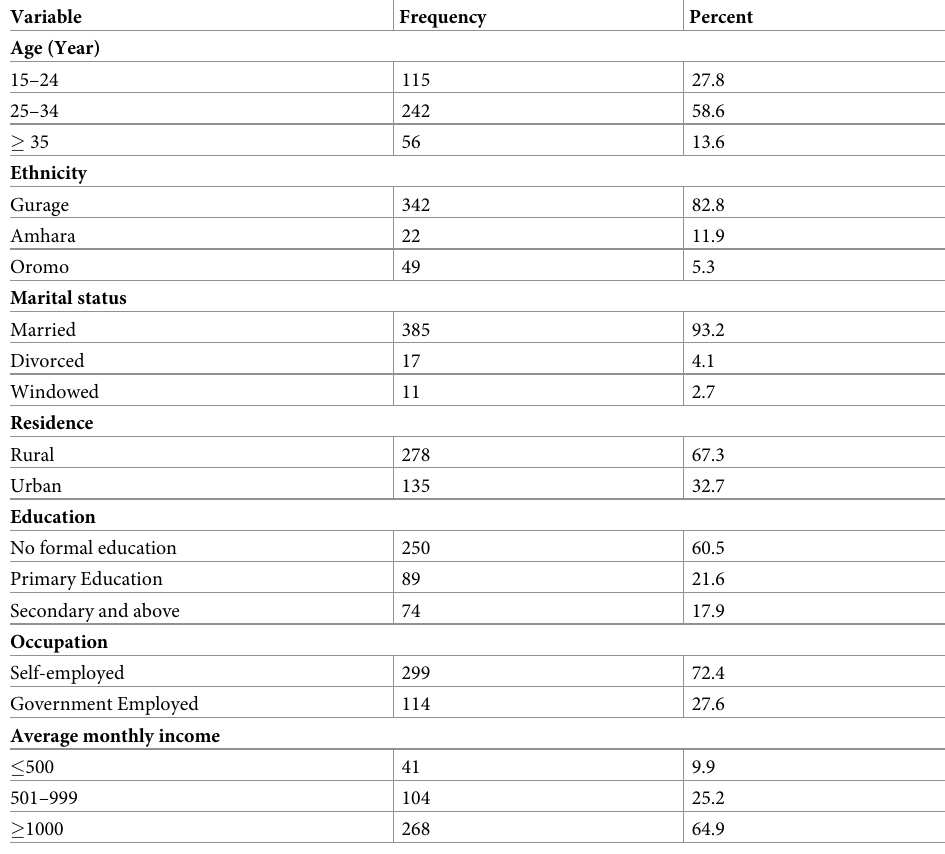
Table 1. Socio-demographic characteristics of study participants in Southern, Ethiopia, 2019 (n =